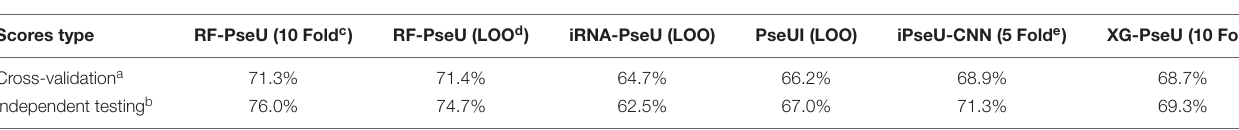
TABLE 4 | Comparison of average accuracies for state-of-the-art